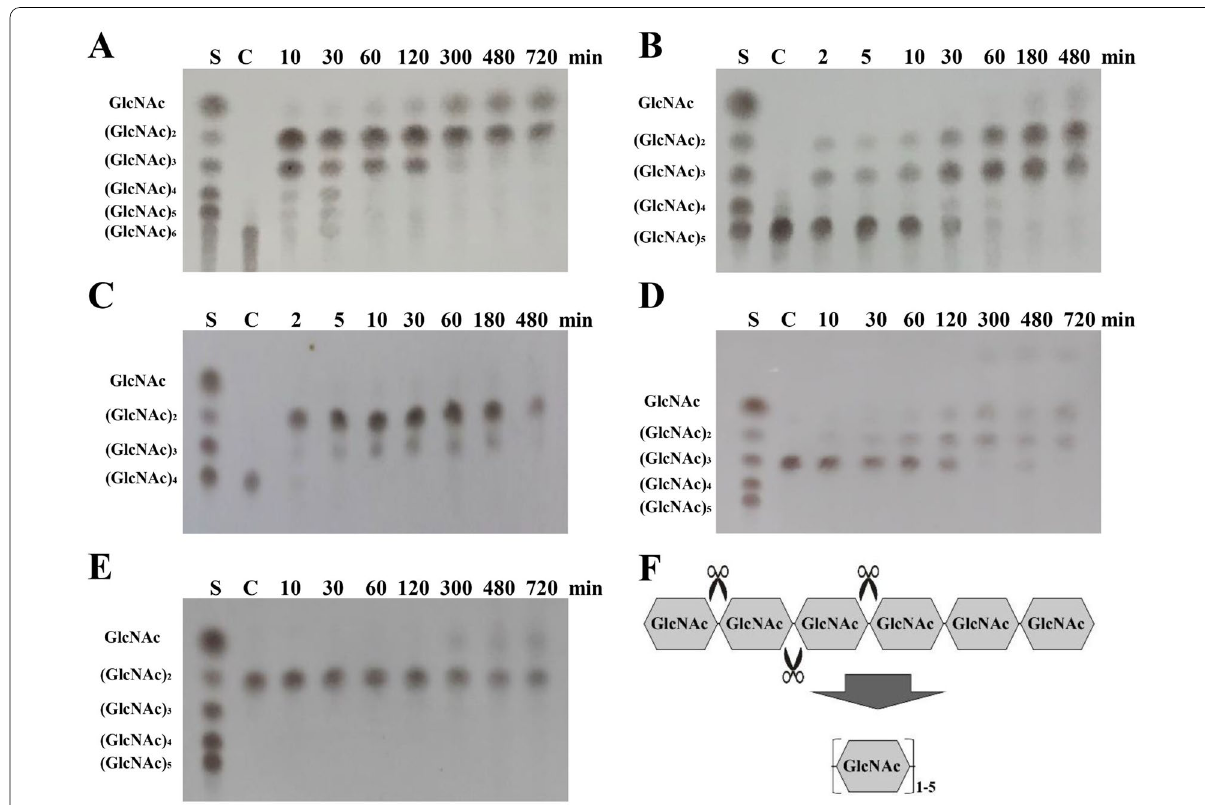
Fig. 3 Detection of chitooligosaccharide hydrolysis products by TLC. A Detection of (GlcNAc) 6 hydrolysis products. B Detection of (GlcNAc) 5 hydrolysis products. C Detection of (GlcNAc) 4 hydrolysis products. D Detection of (GlcNAc) 3 hydrolysis products. (E) Detection of (GlcNAc) 2 hydrolysis products. F Schematic diagram of chito-oligosaccharides degradation. S, 50 mg mL − 1 (GlcNAc) 1–6 mixed standard; C, negative control for chitinase